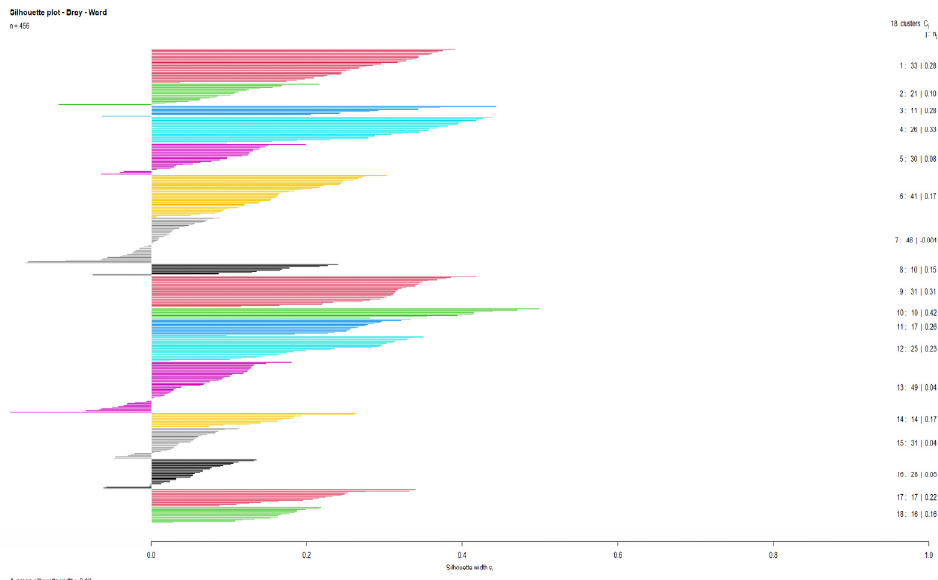
Figure 4. Silhouette width. Plant communities: 1 − Osmundo - Alnetum glutinosae; 2 − Glechomo sardoae- Alnetum glutinosae; 3 − Oenantho crocatae - Alnetum glutinosae; 4 − Carici pallescentis-Alnetum glutinosae; 5 − Aro italici-Alnetum glutinosae; 6 − Carpino betuli-Alnetum glutinosae; 7 − Hyperico hircini-Alnetum glutinosae; 8 − Polysticho setiferi-Alnetum glutinosae; 9 − Angelico sylvestris-Alnetum glutinosae; 10 − Euphorbio corallioides-Alnetum glutinosae; 11 − Asperulo taurinae-Alnetum glutinosae; 12 − Platano orientalis-Alnetum glutinosae; 13 − Eupatorio corsici-Alnetum glutinosae; 14 − Gentiano asclepiadeae- Alnetum glutinosae; 15 − Geranio nodosi-Alnetum glutinosae; 16 − Geranio nodosi-Alnetum glutinosae cornetosum sanguineae; 17 − Aegopodio podagariae-Alnetum glutinosae; 18 − Lamio orvalae-Alnetum glutinosae.